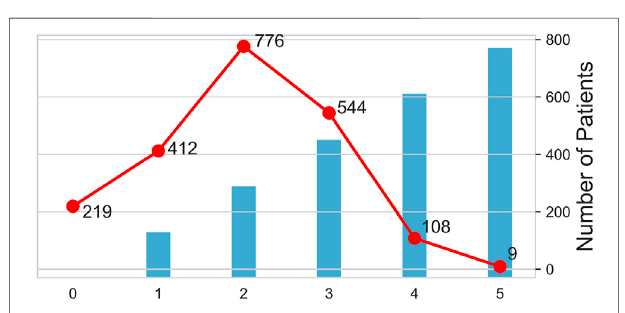
FIGURE 3 | Pattern and number of antibiotics used. The columns show the number of antibiotics used, and the broken lines shows the number of people taking drugs. The horizontal axis shows the number of antibiotics used. 0 indicates that no antibacterial drugs have been used, one indicatesthatonlyoneantibacterialdrughasbeenused,andtwoindicatesthe combination of two antibacterial drugs, and so on for 3, 4, and 5.